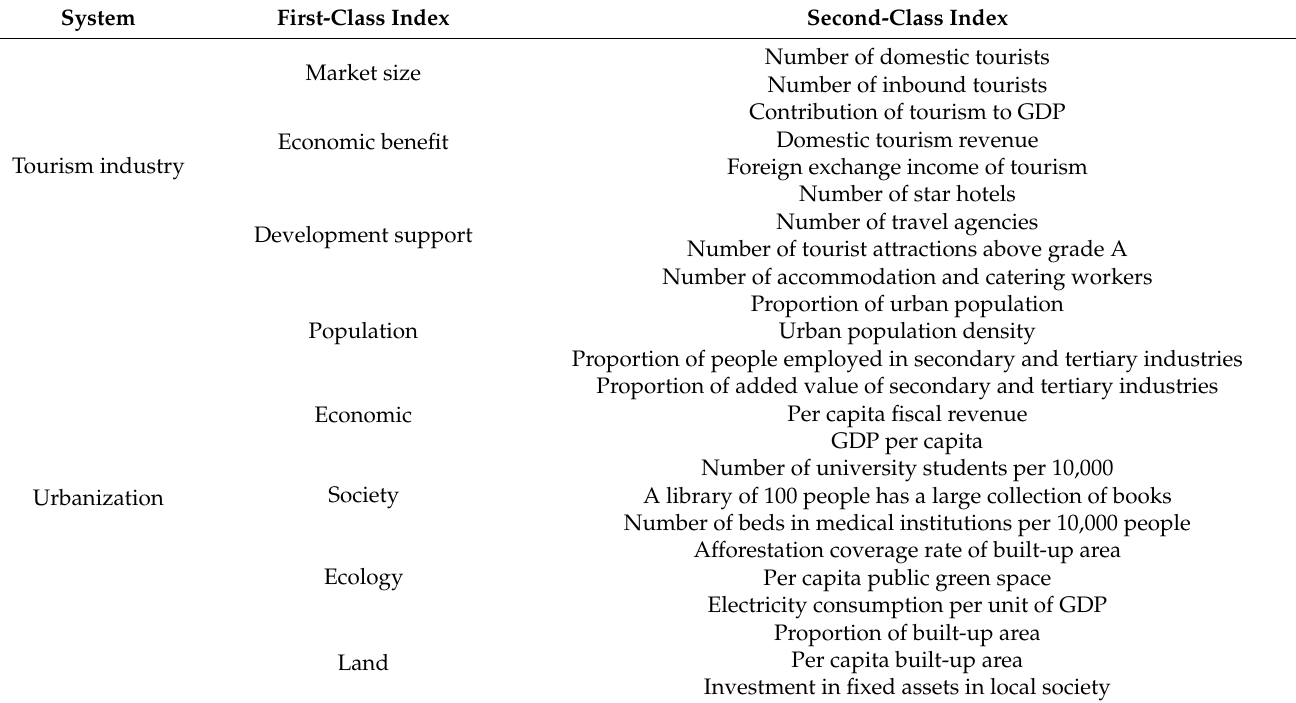
Figure 1. Location of the Yangtze River Delta Urban Agglomeration. Note: The location of the Yangtze River Delta Urban Agglomeration comprises the province-level administrations of Jiangsu, Zhejiang, Anhui, and Shanghai (Jiangsu Province includes the 9 cities of Nanjing (NJ), Yancheng (YC), Yangzhou (YZ), Taizhou (TZh), Nantong (NT), Zhenjiang (ZJ), Changzhou (Czh), Wuxi (WX), and Suzhou (SZh). Anhui Province includes the 8 cities of Hefei (HF), Chuzhou (ChZ), Ma’anshan (MAS), Wuhu (WH), Anqing (AQ), Tongling (TL), Chizhou (CZ), and Xuancheng (XC). Zhejiang Province includes the 8 cities of Hangzhou (HZ), Huzhou (HuZ), Jiaxing (JX), Zhoushan (ZS), Shaoxing (SX), Ningbo (NB), Taizhou (TZ), and Jinhua (JH)). Table 1. The development index of the tourism industry and urbanization.